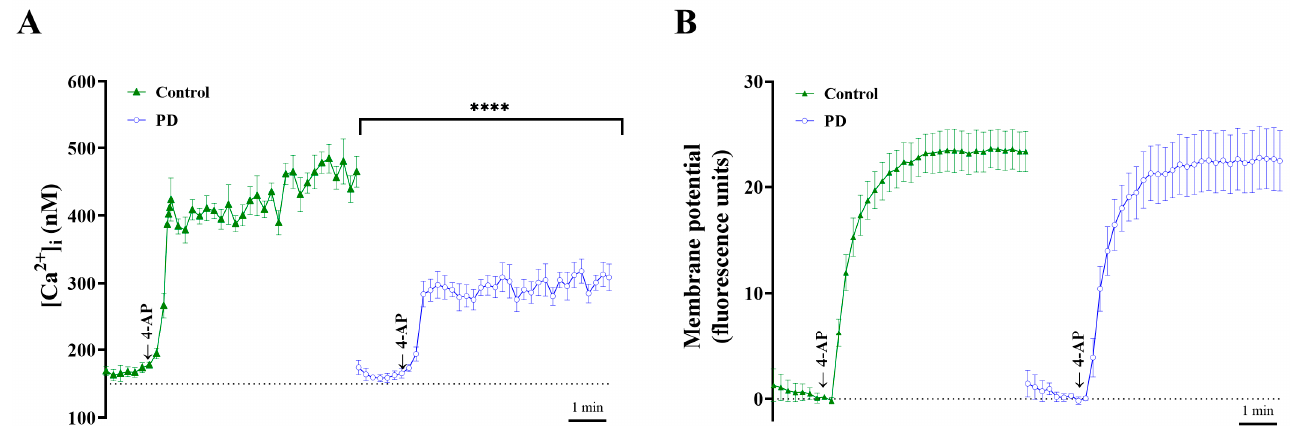
Figure 4. PD attenuates 4-AP-evoked voltage-dependent Ca 2+ influx but shows no effect on the synaptosomal membrane potential. ( A ) lntrasynaptosomal levels of Ca 2+ were measured using the fluorescent indicator Fura-2 (5 µ M). PD (30 µ M) was added 10 min before depolarization with 1 mM 4-AP, and [Ca 2+ ]c was analyzed by spectrometry. ( B ) Depolarization of synaptosomes with 4-AP. The membrane potential was monitored with 5 µM DiSC3(5) in the absence (control) or presence of 30 µM PD. The results are shown as the averages of five independent experiments, and the data represent the means ± SEMs ( n = 5 per group). **** p < 0.0001.